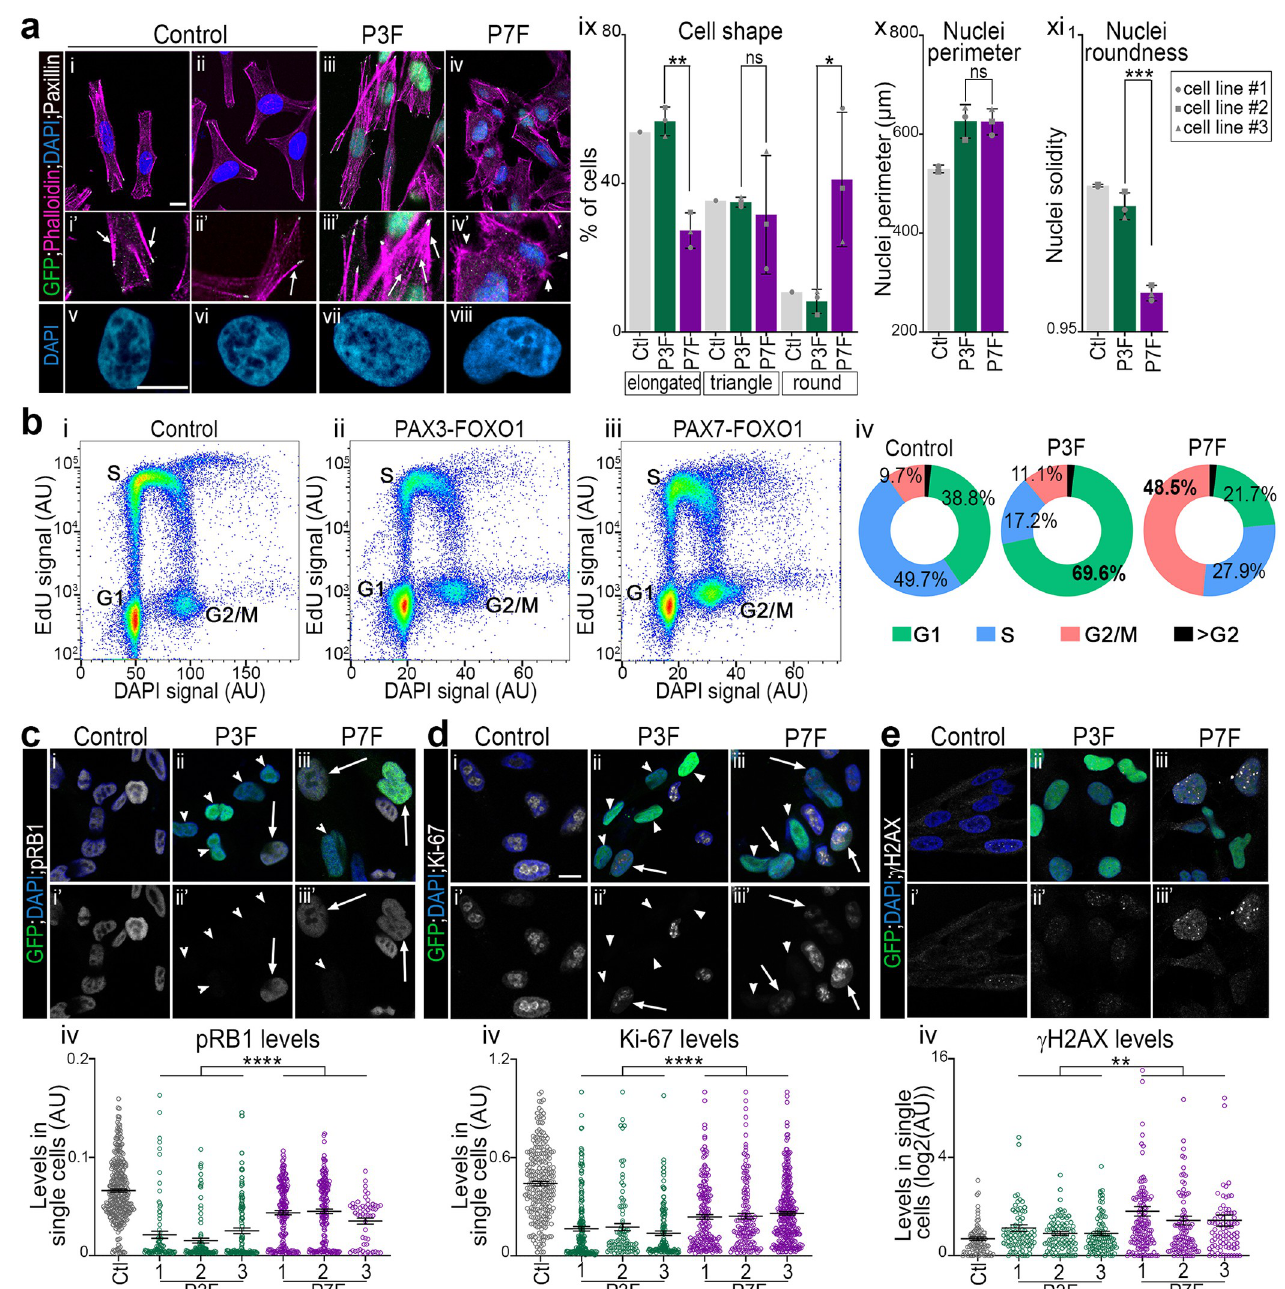
Fig 3. PAX3-FOXO1 & PAX7-FOXO1 activities differentially impact the shape of cells and their cycling behaviour. (a)(i-viii) Immunodetection of Paxillin and GFP, phalloidin based F-actin labelling and DAPI staining on the indicated HFF cell lines treated for 48h with DOX. (ix-xi) Proportion of cells harbouring the indicated cell morphology (ix), quantification of nuclei perimeter (x) and solidity (xi) in the indicated cell lines treated with DOX for 48h (bars: mean ± s.d.; dots: mean value in independent cell lines; Mann-Whitney U test p -value: � : p < 0.05, �� : p < 0.01, ��� : p < 0.001, ns: p > 0.05). (b)(i-iii) FACS plots displaying EdU levels and DNA content (DAPI levels) in control cells and in the GFP + population of a PAX3-FOXO1 and PAX7-FOXO1 cell line treated for 48h with DOX. (iv) Percentage of cells in the indicated cell cycle phase established from plots in i (mean over three experiments and three independent lines). (c-e)(i-iii’) Immunodetection of pRB1, Ki-67, γ H2AX, 53BP1 and GFP and DAPI staining on the indicated HFF cell lines treated for 48h with DOX. (c-e)(iv) Levels of expression of pRB1, Ki-67 and γ H2AX in control, GFP + PAX3-FOXO1 and GFP + PAX7-FOXO1 cells treated for 48h with DOX (dots: cell values, bars: mean ± s.e.m., two-way-ANOVA p -values evaluating the similarities between PAX3-FOXO1 and PAX7-FOX1 cells lines: ���� : p < 0.0001).